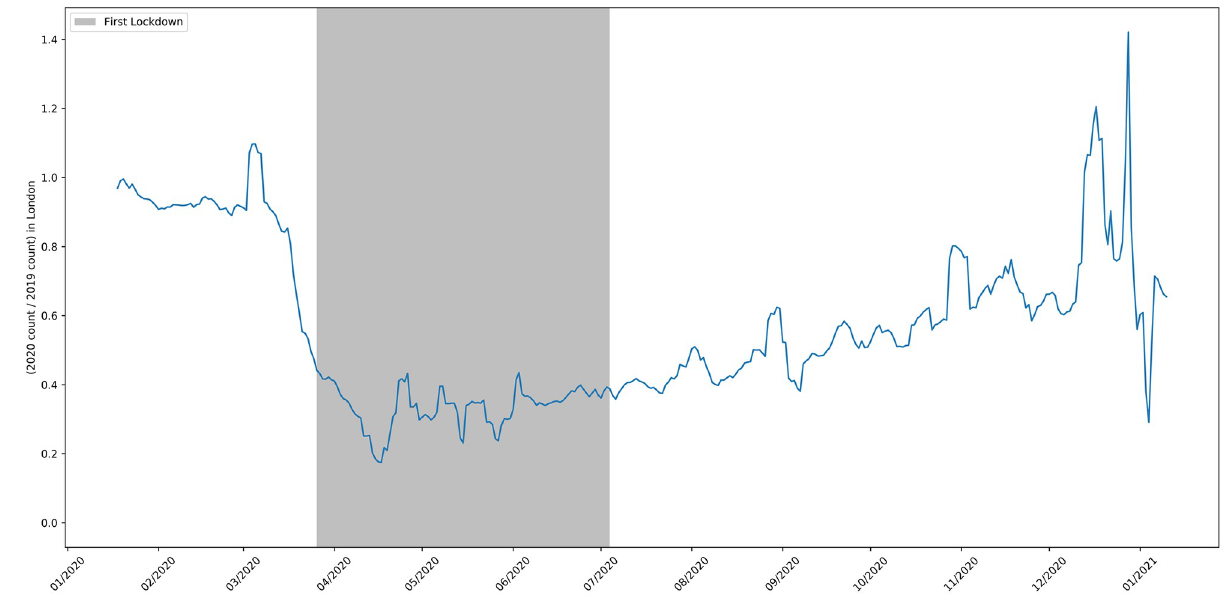
Fig 11. The 2020 to 2019 ratio of job adverts in the Greater London area.